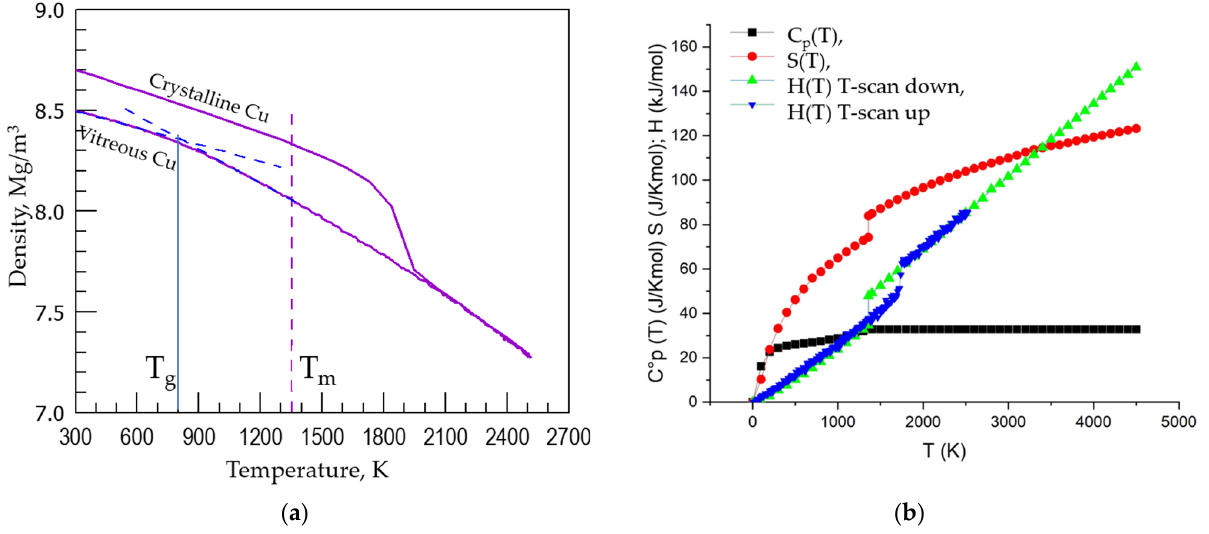
Figure 3. ( a ) Density changes on heating and cooling of crystalline and vitreous Cu respectively where T m is the melting temperature (1358 K) and T g is the glass transition temperature obtained at the given cooling rate q = 1 × 10 13 K/s. ( b ) Thermodynamic functions of Cu as function of temperature demonstrating characteristic changes at T g and T m . There is no change at T g for C p (T) because the data presented are for crystalline Cu taken from the Reference [37] and the change is seen only at T m . Data of current work are given in the blue colour.